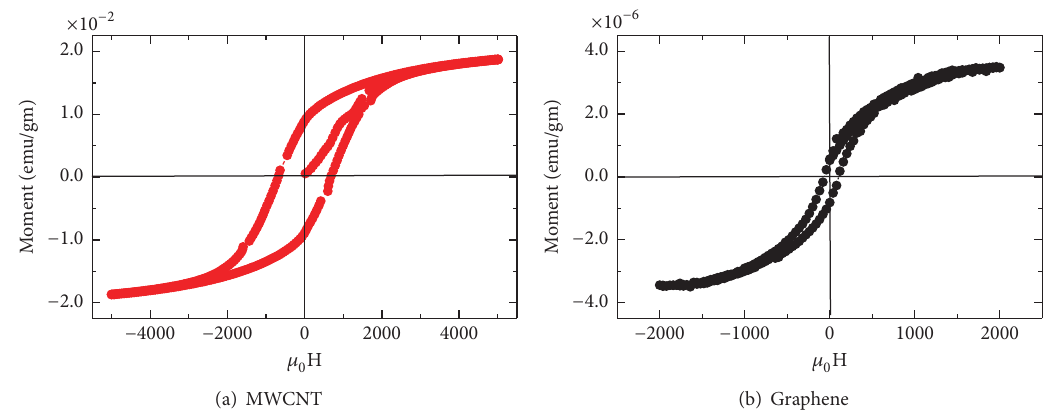
Figure 6: Field-dependent magnetization M-H hysteresis loop of (a) MWCNTs and (b)